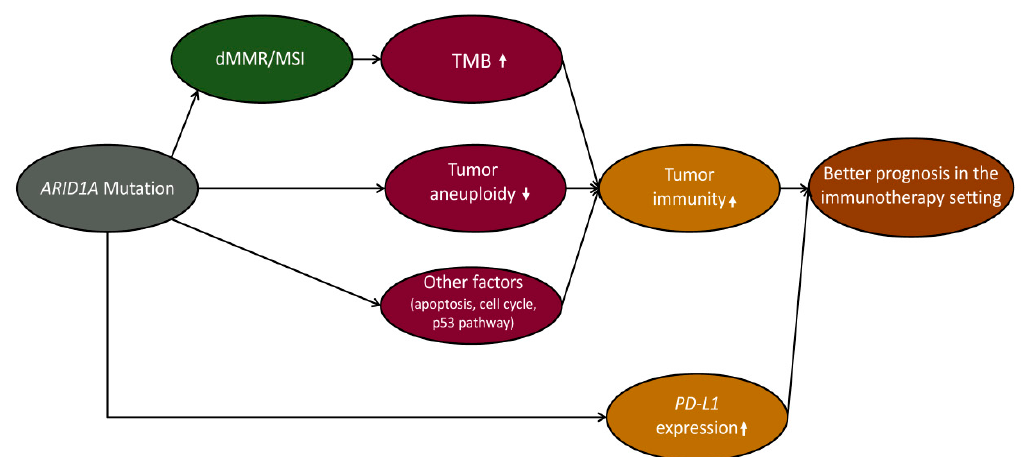
Figure 5. The mechanism by which the ARID1A mutation contributes to the elevated tumor immunity and tumor immunotherapy response, as well as favorable clinical outcomes in cancer patients receiving anti-PD-1/PD-L1/CTLA-4 immunotherapy.